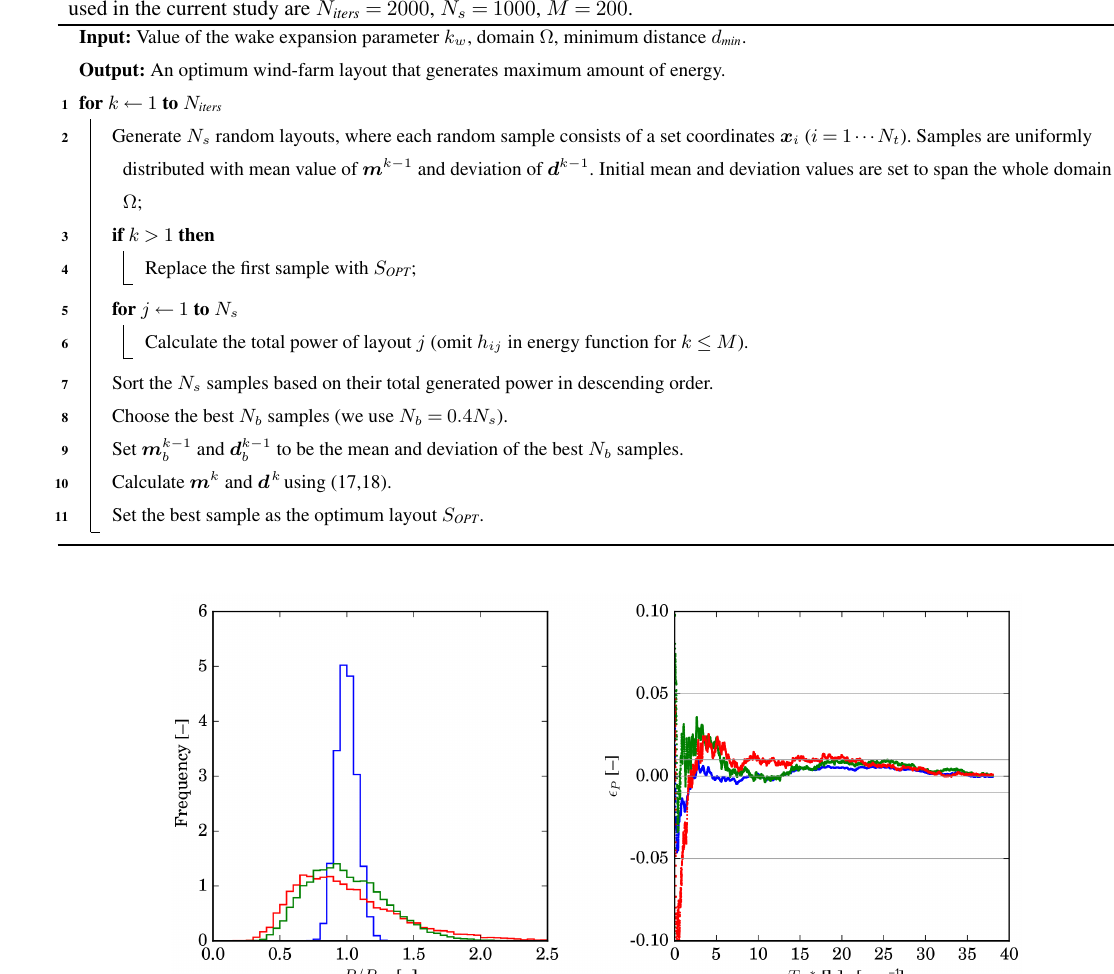
Algorithm 2: The outline of the cross–entropy optimisation method for finding the optimum wind-farm layout. Values used in the current study are N iters = 2000 , N s = 1000 , M = 200 .